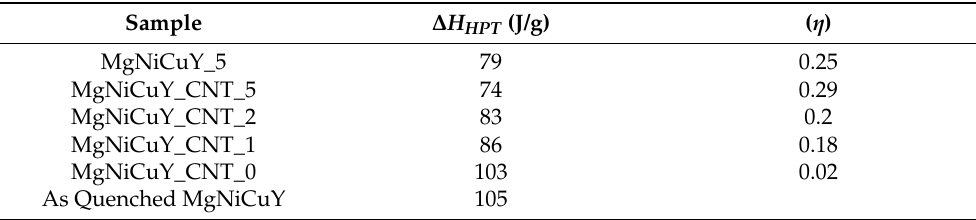
Figure 5. Continuous-heating DSC curves corresponding to the as-quenched Mg 65 Ni 20 Cu 5 Y 10 alloy and CNT-containing HPT disks. Table 1. Total exothermic heat release ( ∆ H HPT ) obtained for the HPT disks and the calculated crystalline fraction ( η )